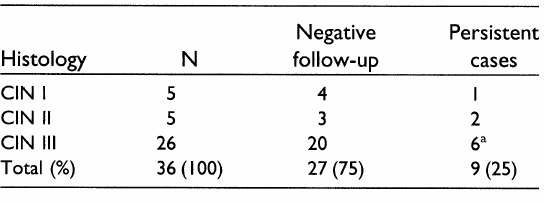
TABLE I. Pretreatment histology and clinical evolution after DLLE